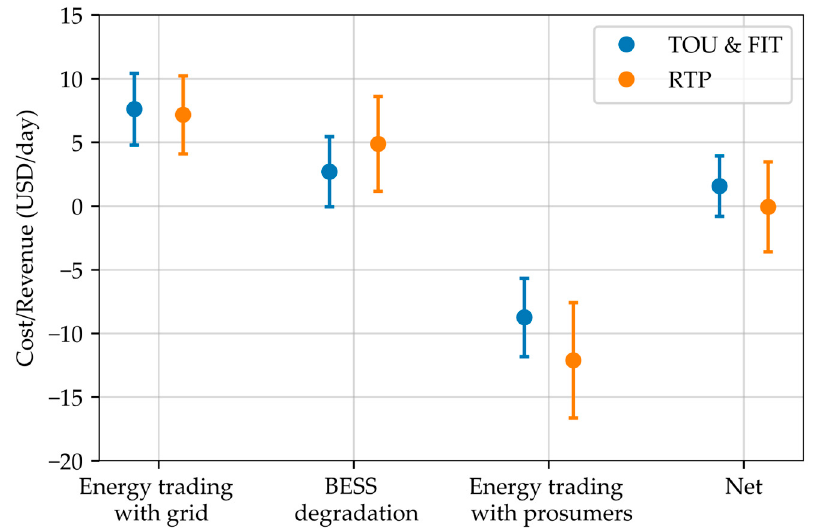
Figure 10. The overall objective values of the aggregator. Table 5. The mean and standard deviation of each objective function of the aggregator .